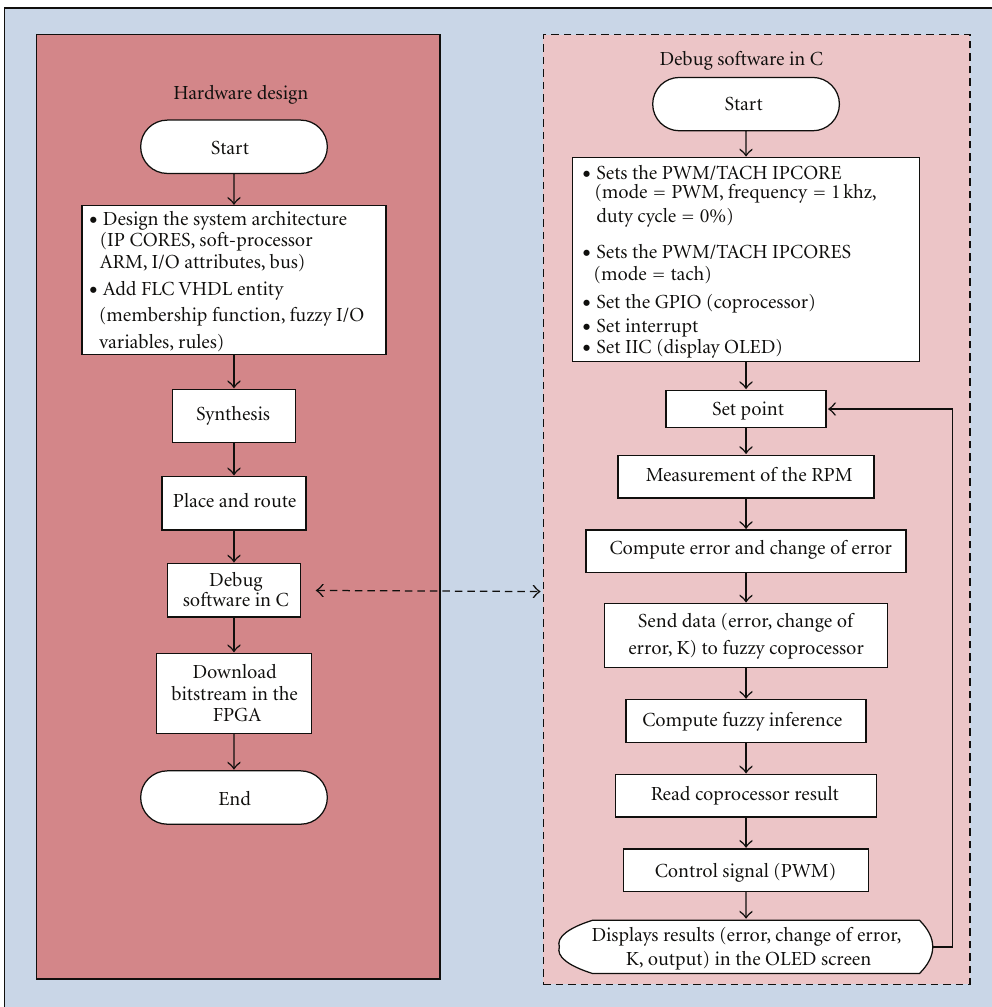
Figure 3: Flow diagram of the debugging process of a C program executed in the FPGA base